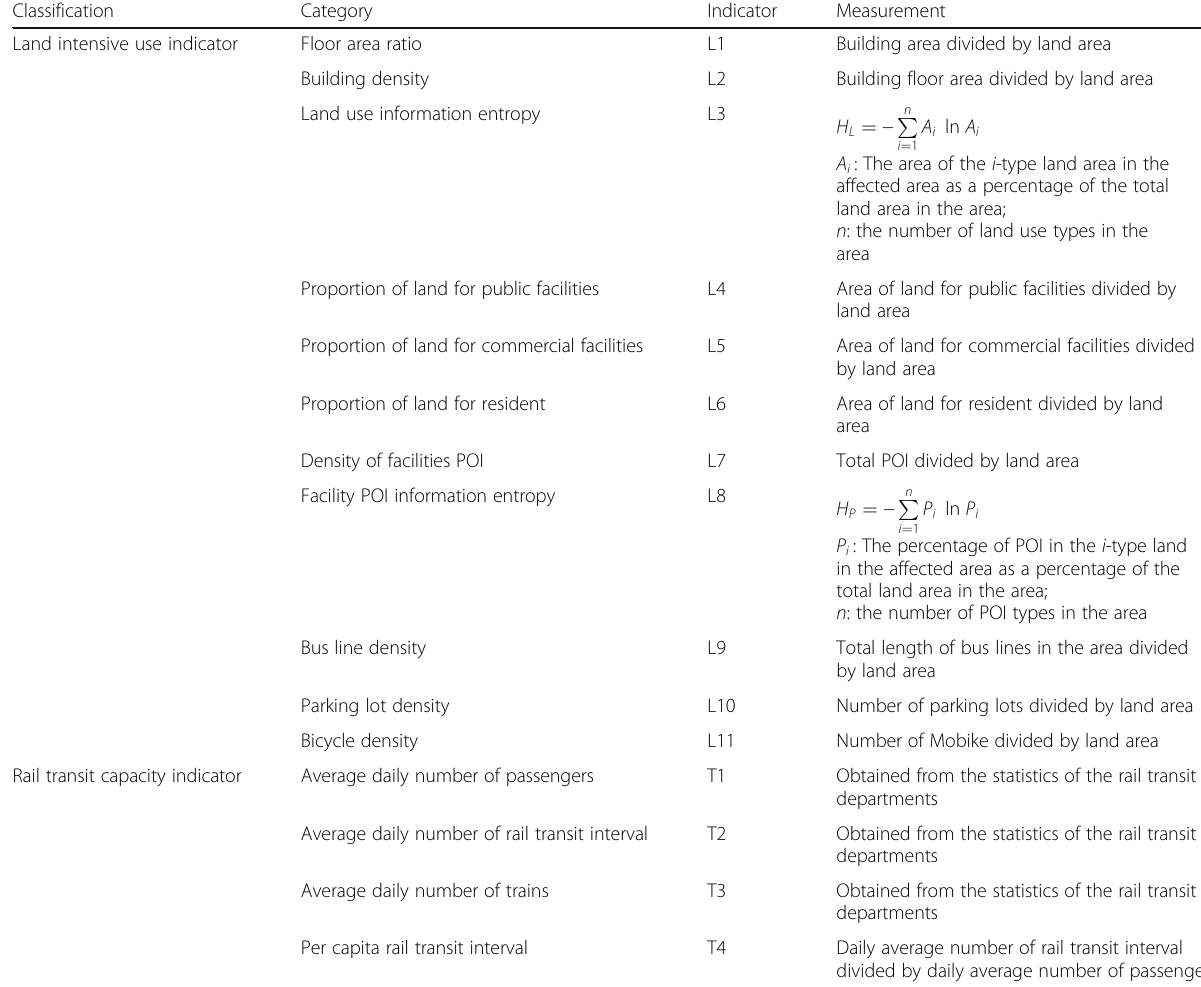
Table 4 Definition of evaluating indicators